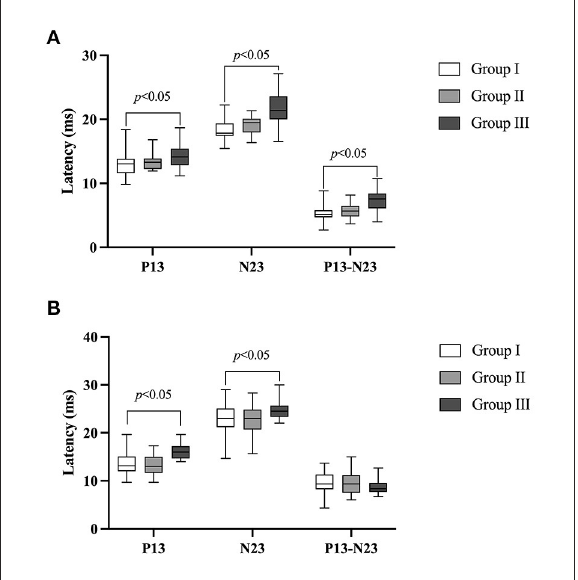
FIGURE3 Comparison of the P13 and N23 latencies and P13-N23 interval of ACS-cVEMP and BCV-cVEMP. (A) Comparison of the P13 and N23 latencies and P13-N23 interval of ACS-cVEMP. The white box plot represented group I ( n = 24 ears), light gray box plot represented group II ( n = 18 ears), dark gray box plot represented group III ( n = 40 ears). (B) Comparison of the P13 and N23 latencies and P13-N23 interval of BCV-cVEMP. The white box plot represented group I ( n = 22 ears), light gray box plot represented group II ( n = 21 ears), dark gray box plot represented group III ( n = 40 ears). There was no significant difference of ACS-cVEMP in P13, N23 latency or P13-N23 interval between group I and group II. Significant differences were observed in all those parameters between groups I and group III. There was no significant difference of BCV-cVEMP in terms of P13 latency, N23 latency or P13-N23 interval between group I and group II. P13 and N23 latencies presented in Group III were significantly longer compared with group I, but not in the P13-N23 interval. In this study, no parameter comparison was made between group II and group III. Group I: Normal hearing ears from infants; Group II: Sensorineural hearing loss ears from infants; Group III: Normal Hearing ears from